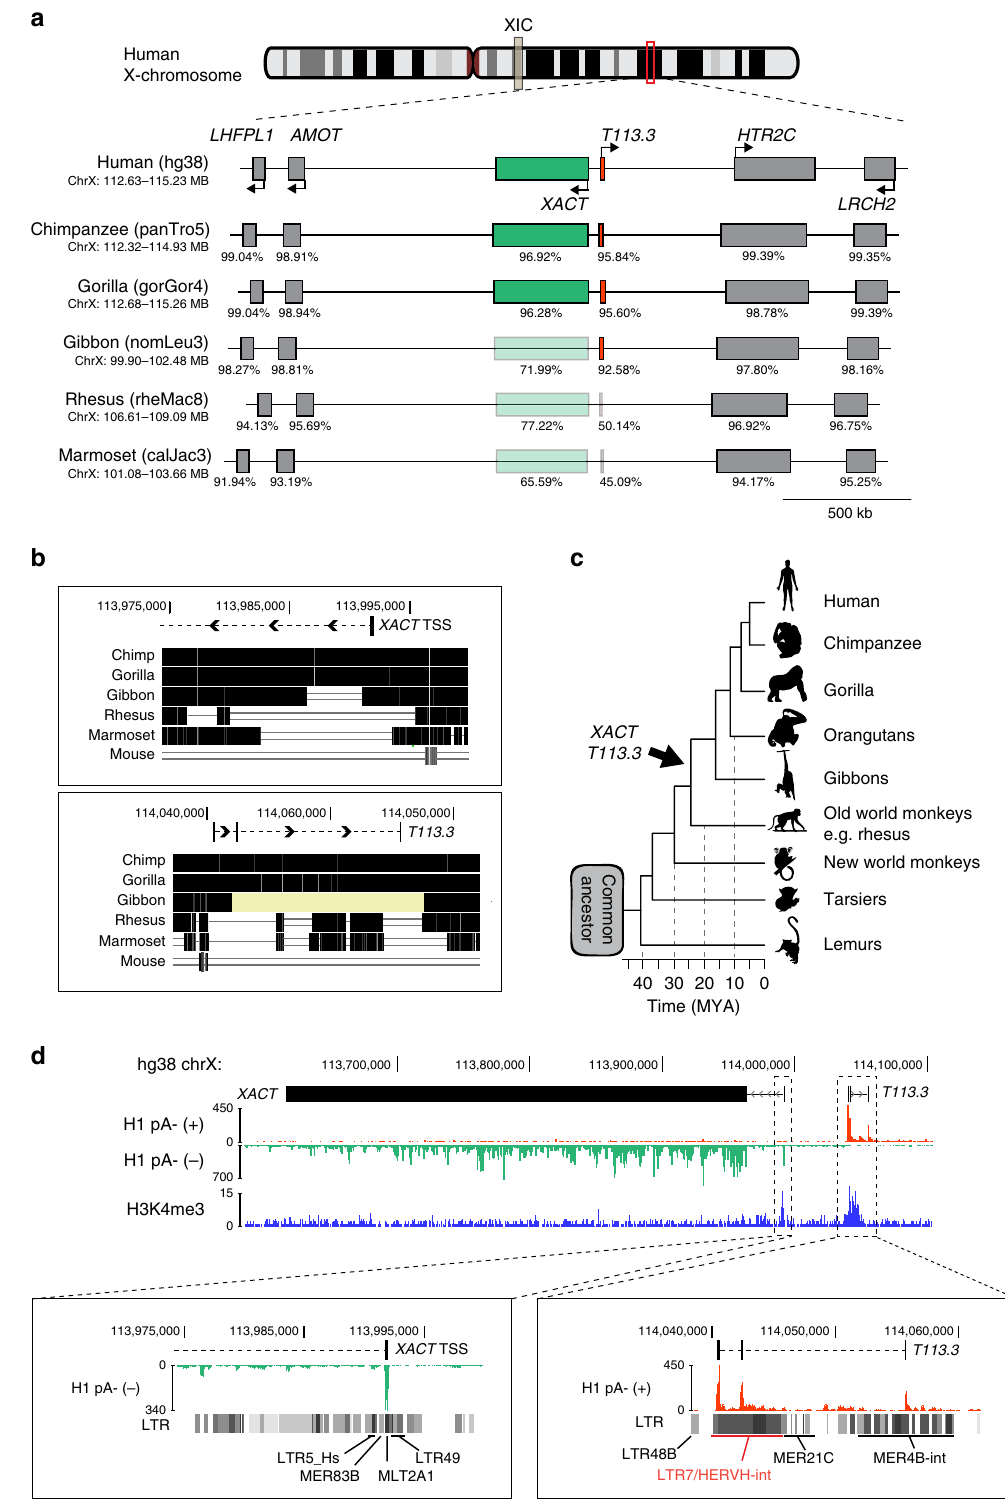
to different groups: LTR5_HS, MER83B, MLT2A1, and LTR49. Rapid ampli fi cation of cDNA ends has previously shown that the MLT2A1 element corresponds to the TSS of XACT 35 . The T113.3 gene derives from the insertion of a 5.1 kb fragment of a